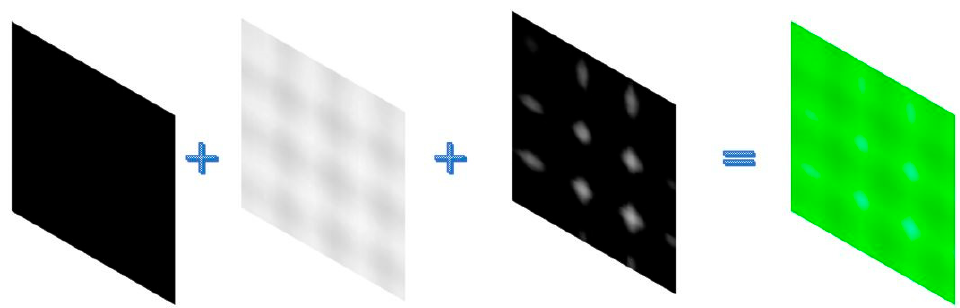
Figure 8. Overlapping GASF matrices.